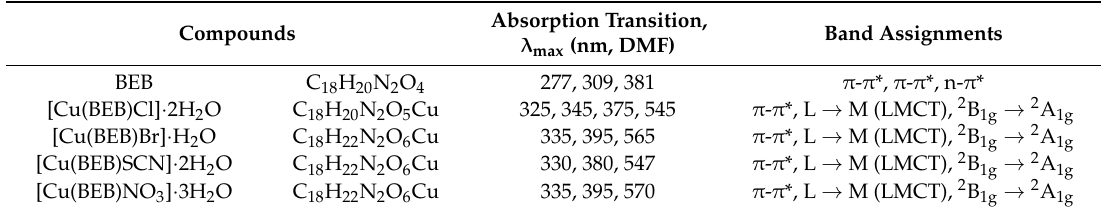
Table 3. Absorption data, band assignments of BEB ligand and its Cu(II)